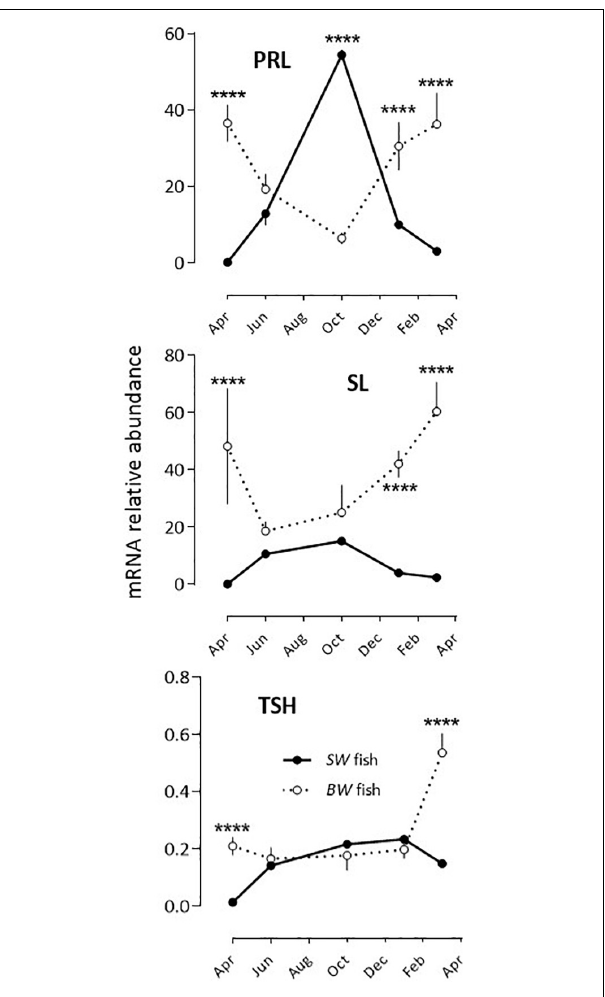
FIGURE 3 | Relative annual variations in PRL, SL and TSH mRNA abundance in sea bass pituitaries in vivo . Same conditions as indicate in the legend of Figure 1 . Mean ± S.E.M. ( n = 6). Two-way ANOVA ( Table 2 ) and Holm-Sidak’s post hoc test was used for comparison of means between